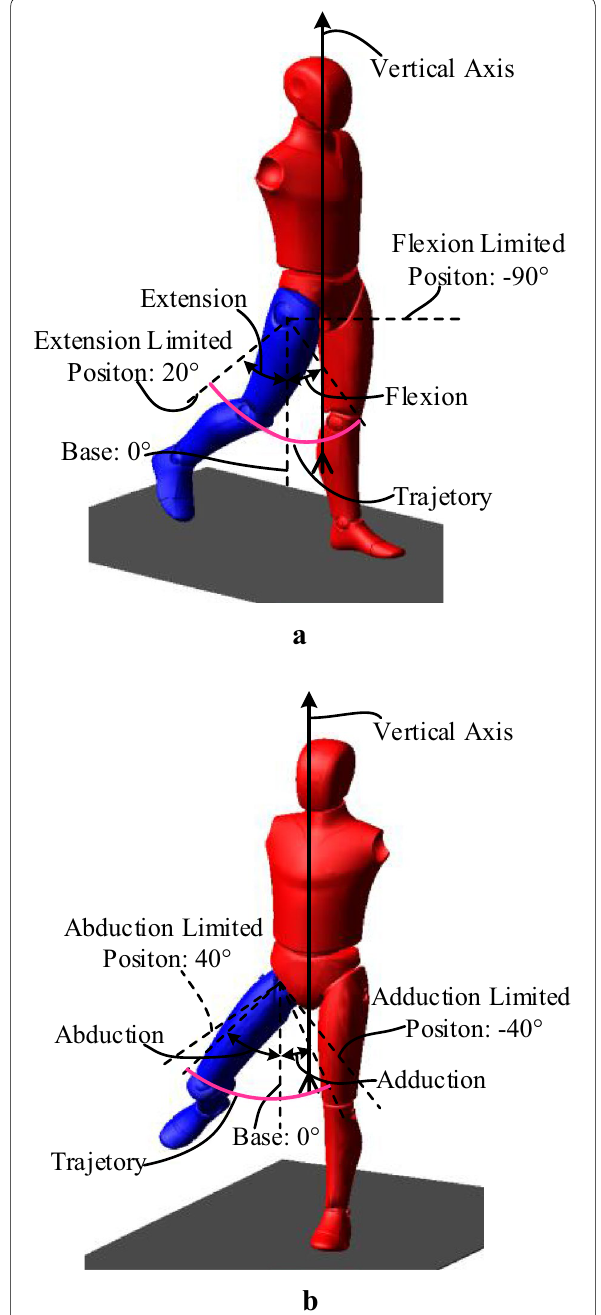
Figure 2 Motion characteristics of a human hip joint: a flexion and extension; b abduction and adduction